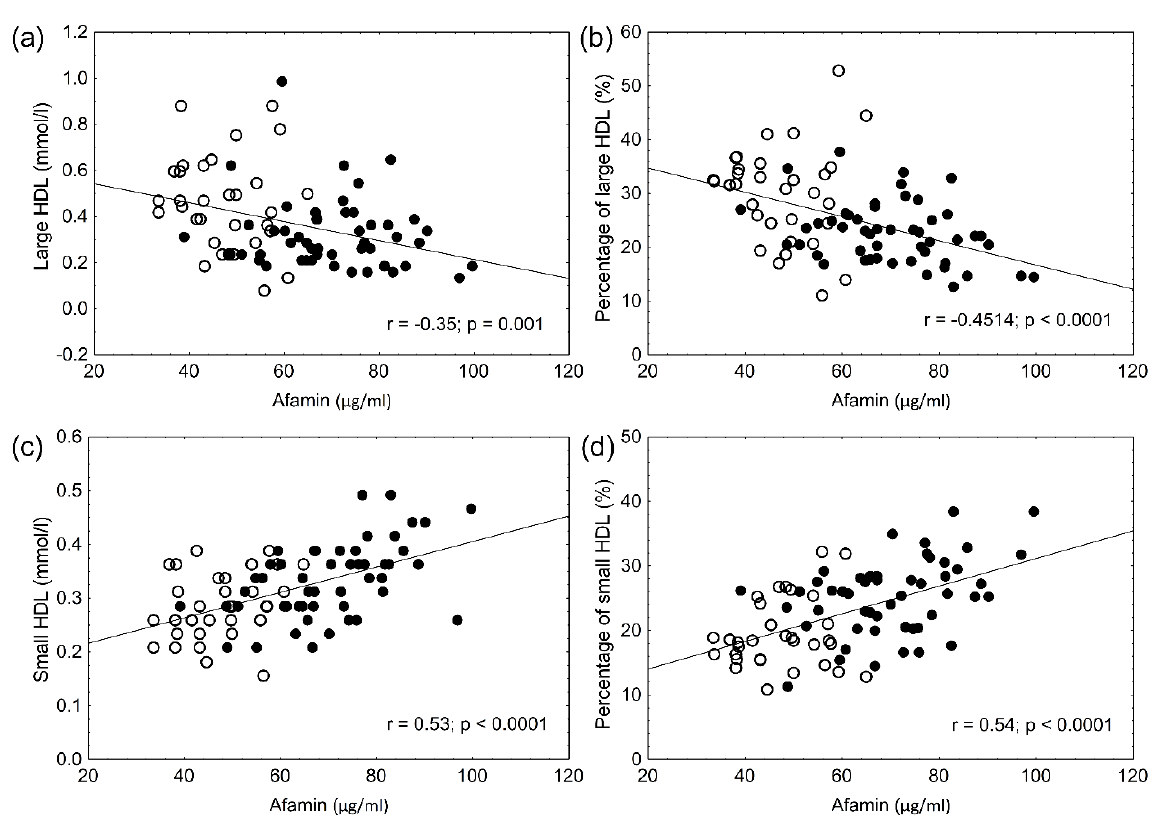
Figure 2. Correlations between concentration of afamin and the level ( a ) and percentage ( b) of large HDL subpopulation and between concentration of afamin and level ( c ) and percentage ( d ) of small HDL subpopulation in the study participants (● obese non-diabetic patients vs. ○ l ean controls).